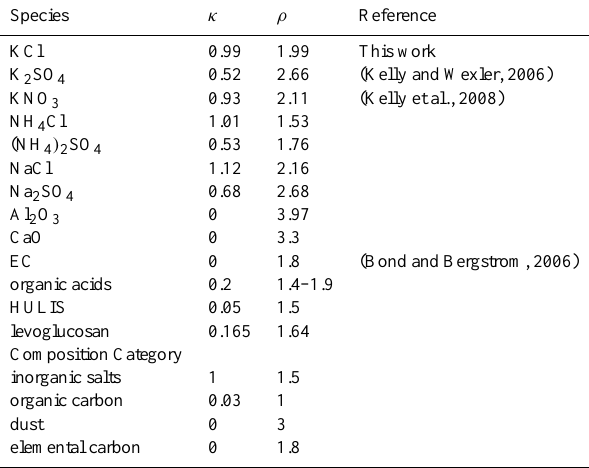
Table 1. Values of hygroscopic parameter κ and dry bulk density ρ for compounds relevant to biomass smoke and used to approximate values for four composition categories listed as the end of Table 1. Unless noted, κ values are from Petters and Kreidenweis (2007) and densities from Lide